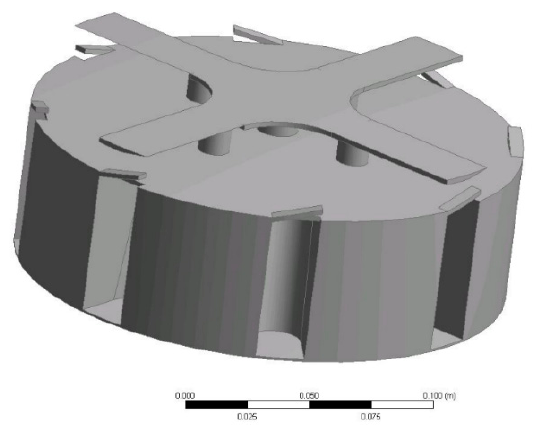
Figure 1. Adjusted rotor Figure 1 . Adjusted rotor geometry.